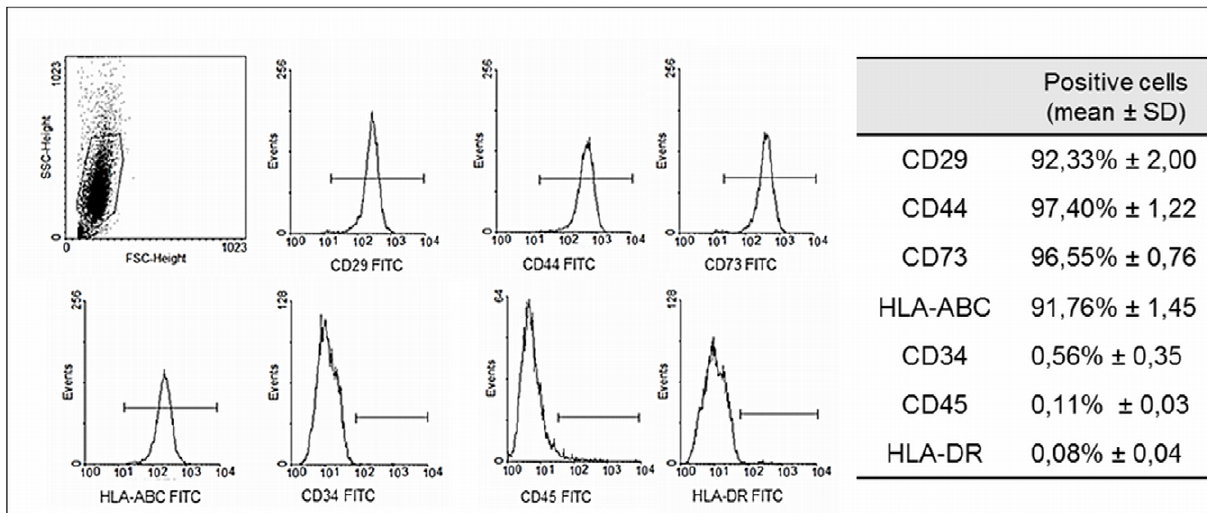
Figure 2. Flow cytometry analysis of hASCs. The expression pattern of specific antigens on the surface of the hASCs is depicted with representative histograms and the expression of each marker. The cell population expressed CD29, CD44, CD73 and HLA-ABC, and did not express CD34, CD45 and HLA-DR.